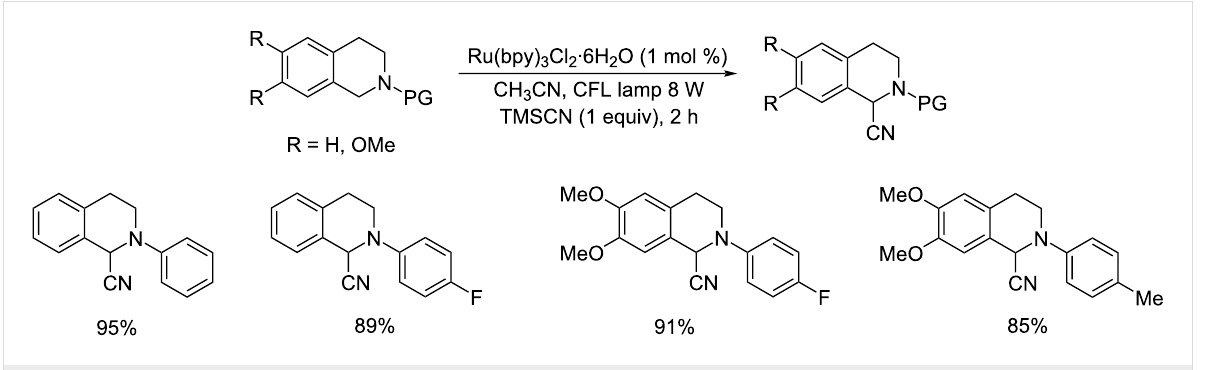
Scheme 22: Strecker-type functionalization of N -aryl-substituted tetrahydroisoquinolines under flow conditions.